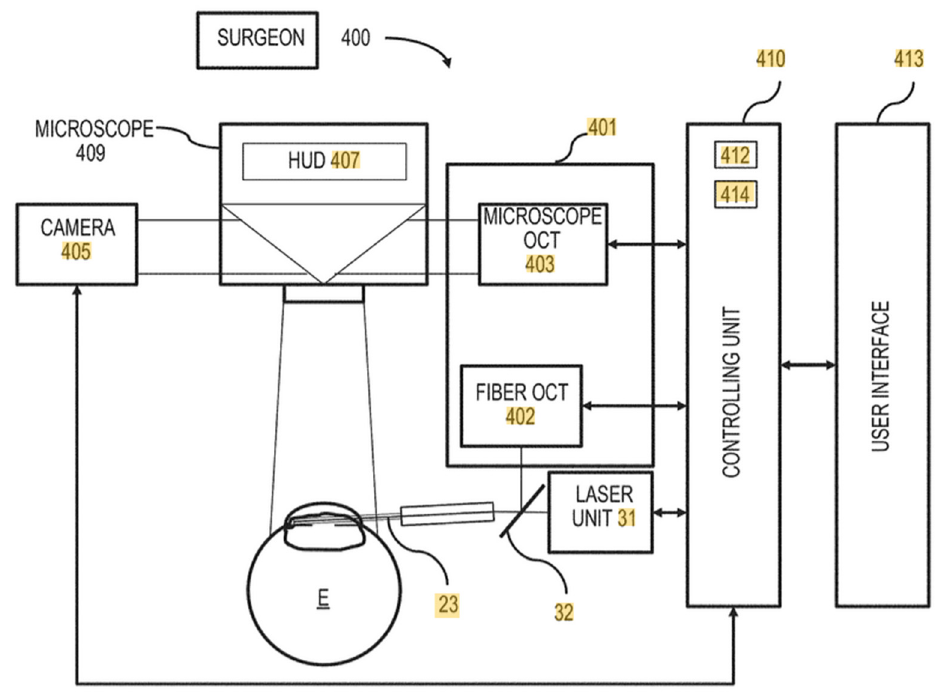
Figure 3. Guided ELT GEN 2 Schematic. Berlin, MS, inventor: Methods and Systems for OCT Guided Glaucoma Surgery United States patent US 10,517,760 B2. 31 December 2019.